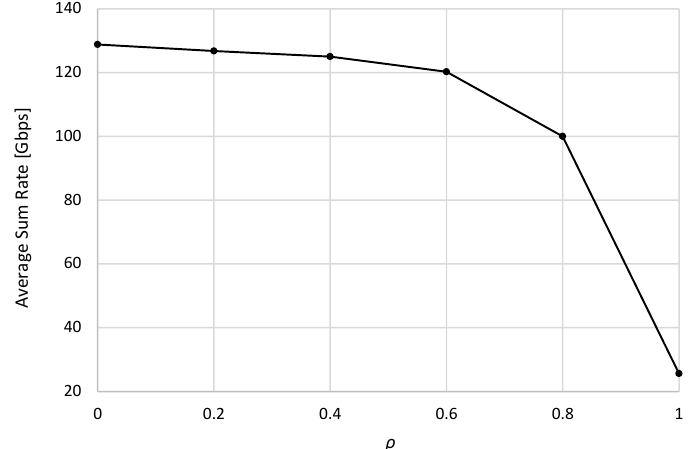
Figure 3. Average sum rate against the value of ρ .